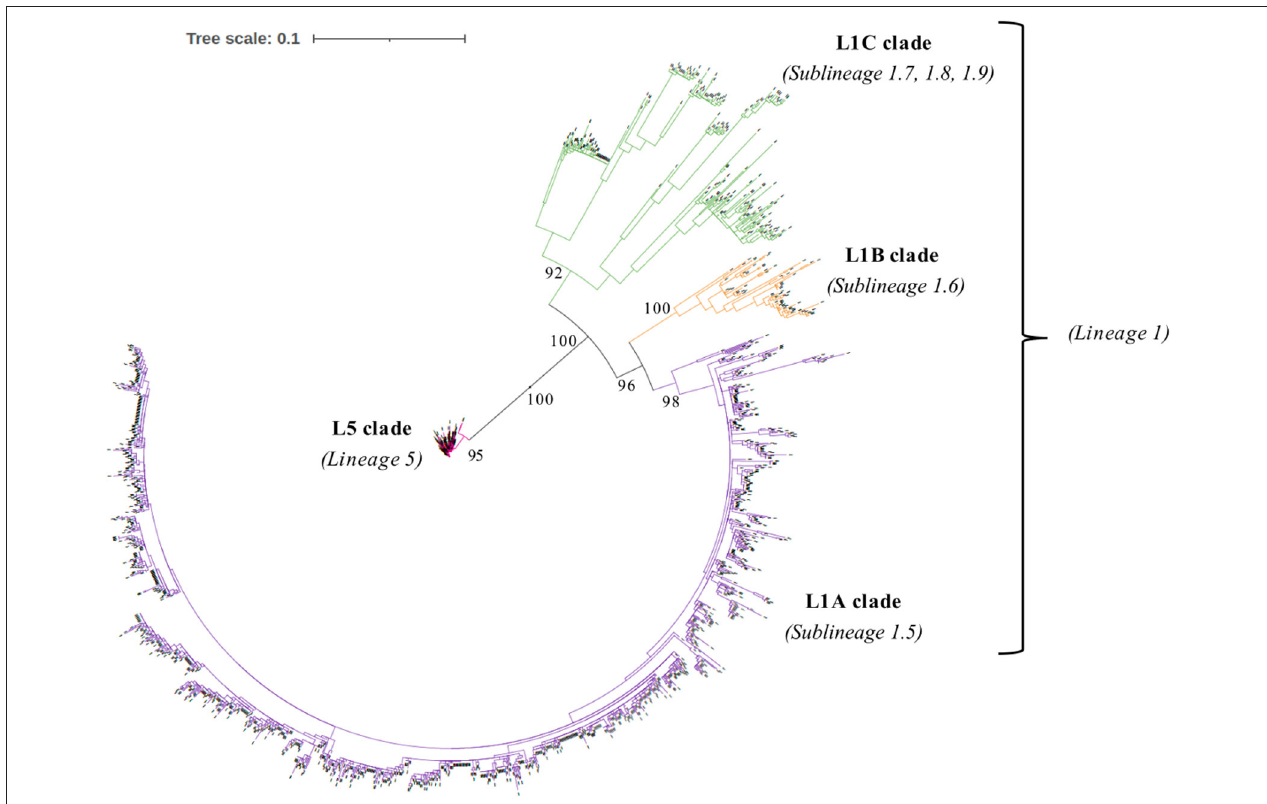
FIGURE 2 | The phylogeny of 1931 field Porcine reproductive and respiratory syndrome virus (PRRSV) field strains estimated by maximum likelihood approach based on the nucleotide sequences of open reading frame 5 (ORF5)